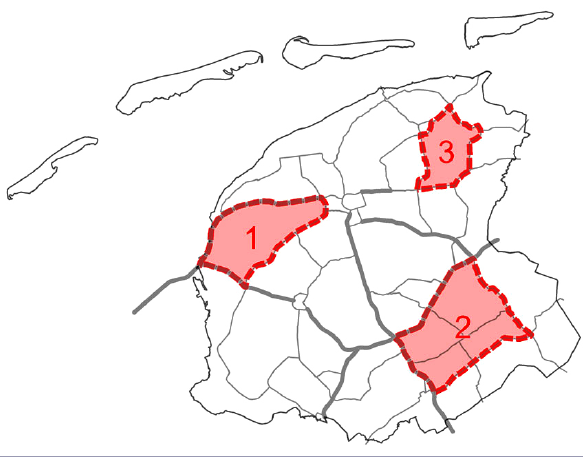
Fig. 2 . Study areas of road typology in the Province of Friesland.